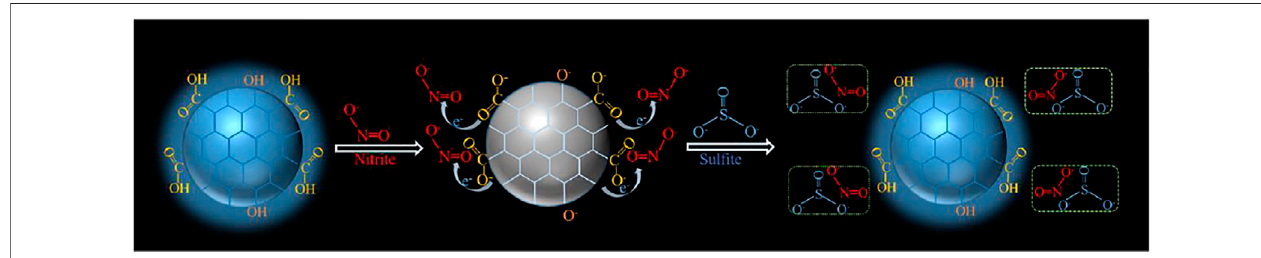
FIGURE 7 | Schematic diagram of CDs with NO 2- and SO 32- .